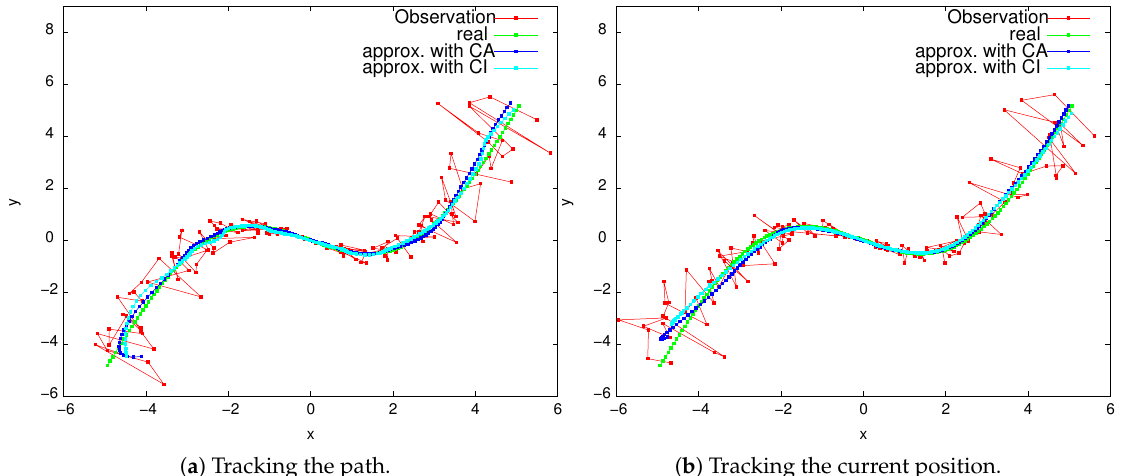
Figure 7. The filter performance in estimating ( a ) the path and ( b ) the current position, when error correlation is taken into account. Note that the true dynamics is given by Equation